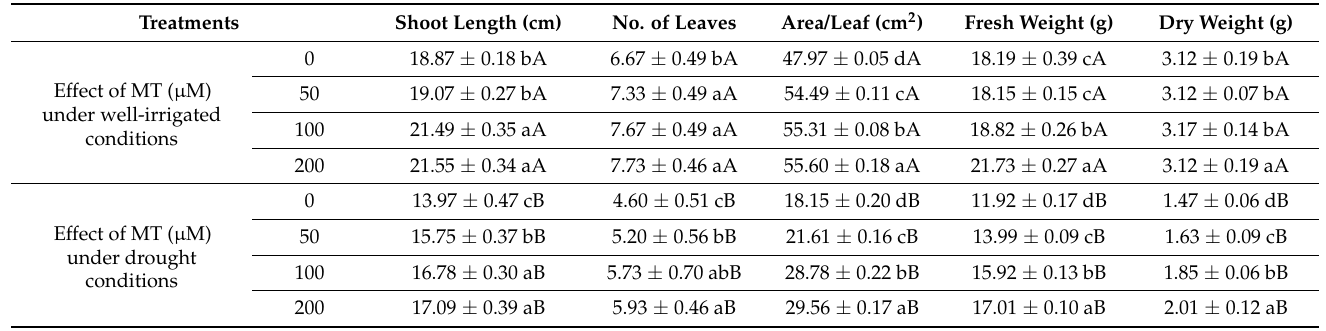
Table 2. Effects of exogenous melatonin application on the vegetative growth traits of R. asiaticus plants with/without drought stress.